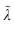
CV deviance of the penalized GLM for participant #17 as a function of regularization parameter λ.The minimum value of the CVD function is indicated with a blue circle, and the optimal lambda λ˜ is indicated with a red circle. Examples of ACIs obtained with different values for this participant are shown below.